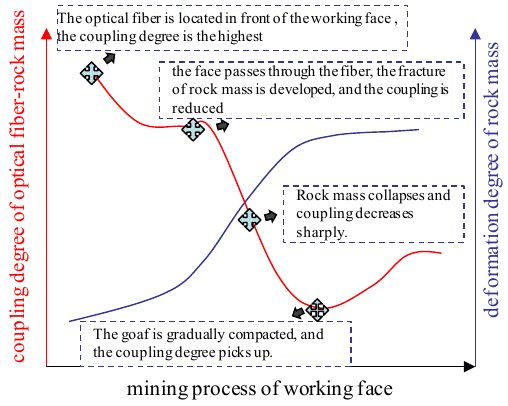
Figure 7. Theoretical model of coupling relationship between rock and optical fiber .